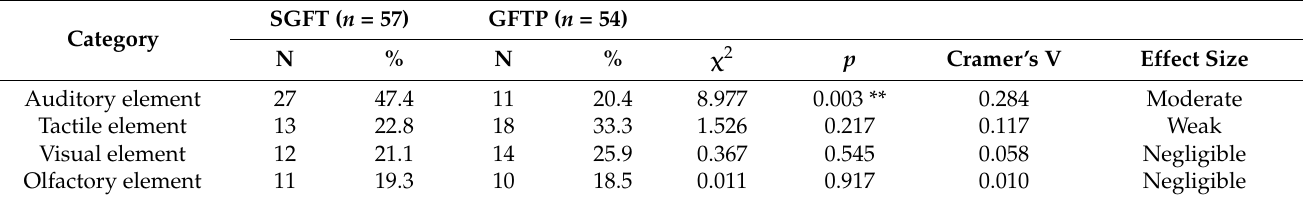
Table 2. Written response category and frequencies on forest healing factors by type of forest therapy activity. Category Auditory